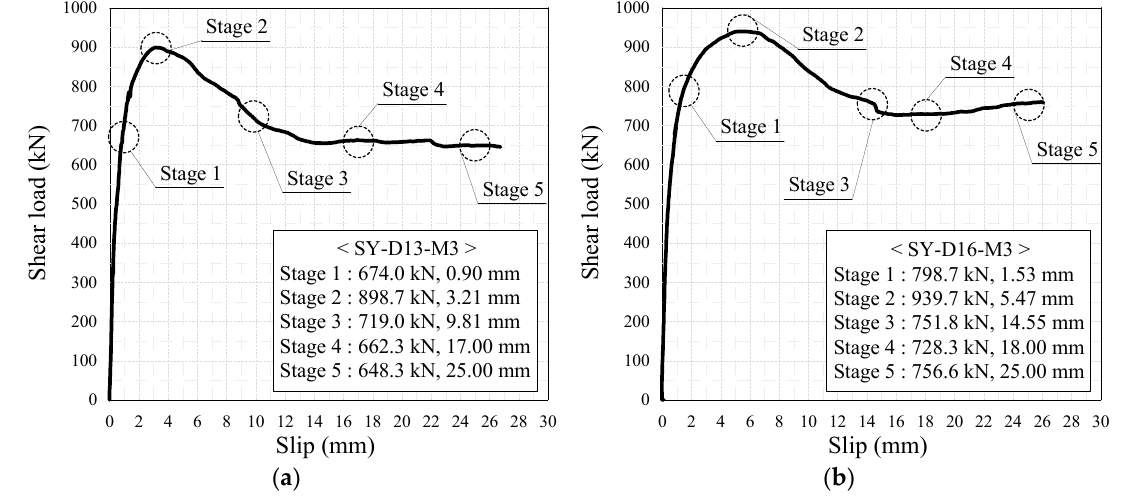
Figure 8. Loading stage: ( a ) SY-D13-M3; ( b ) SY-D16-M3.